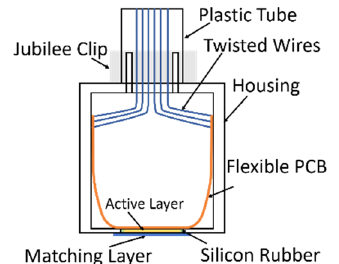
Figure 4. Illustration of prototype transducer structure.